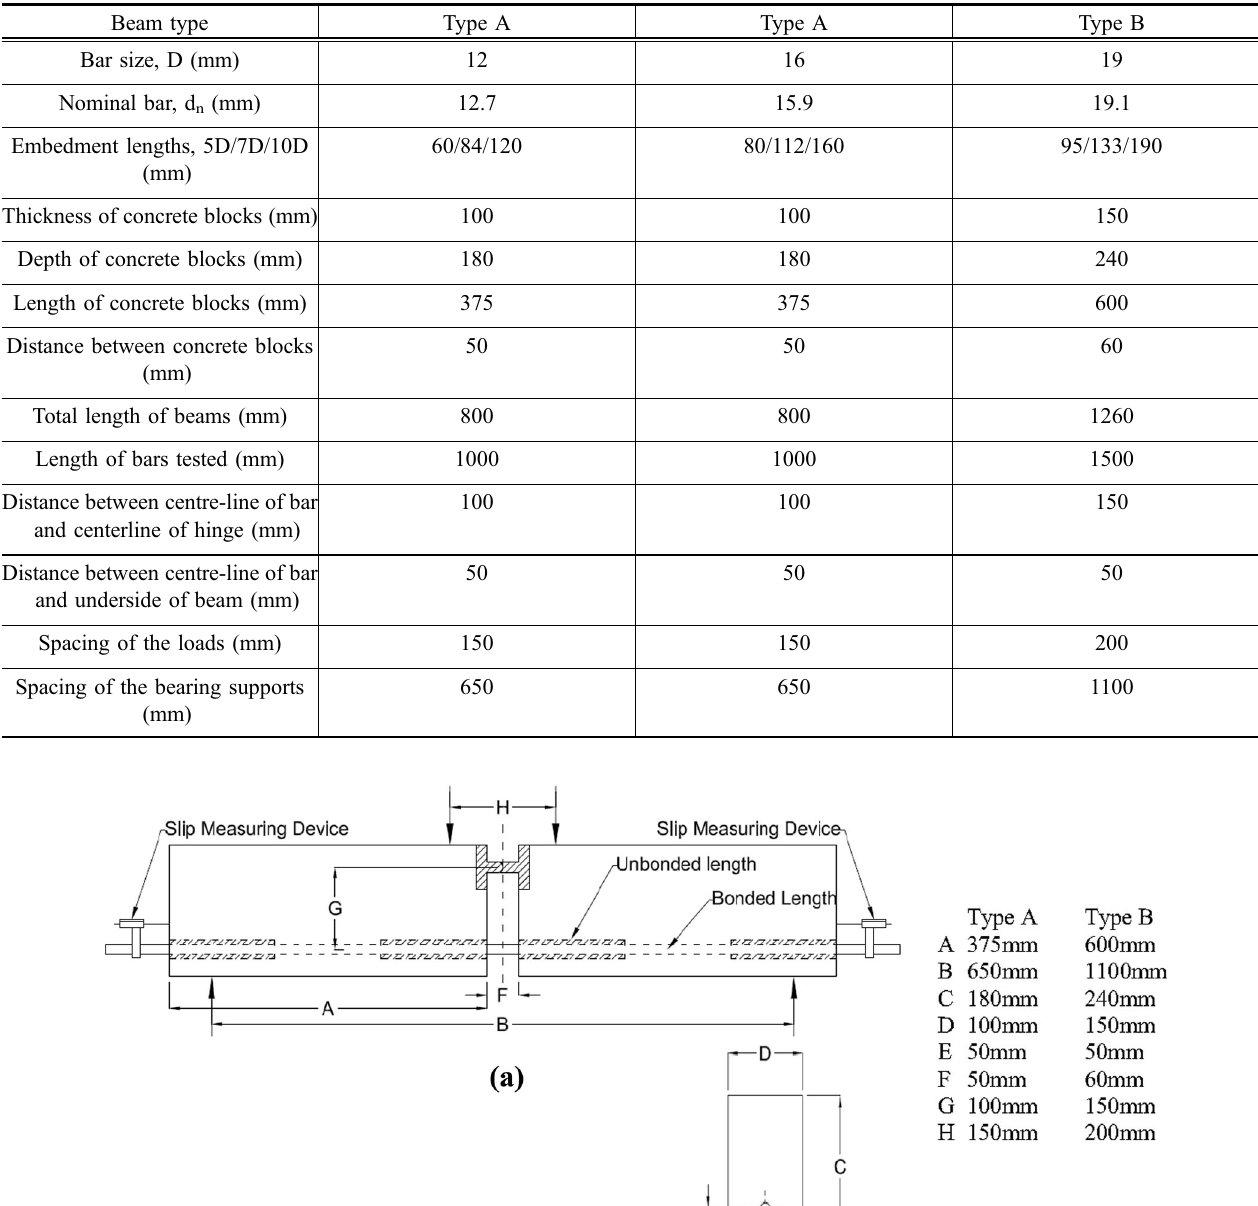
Table 3 Dimensions of beam specimens.